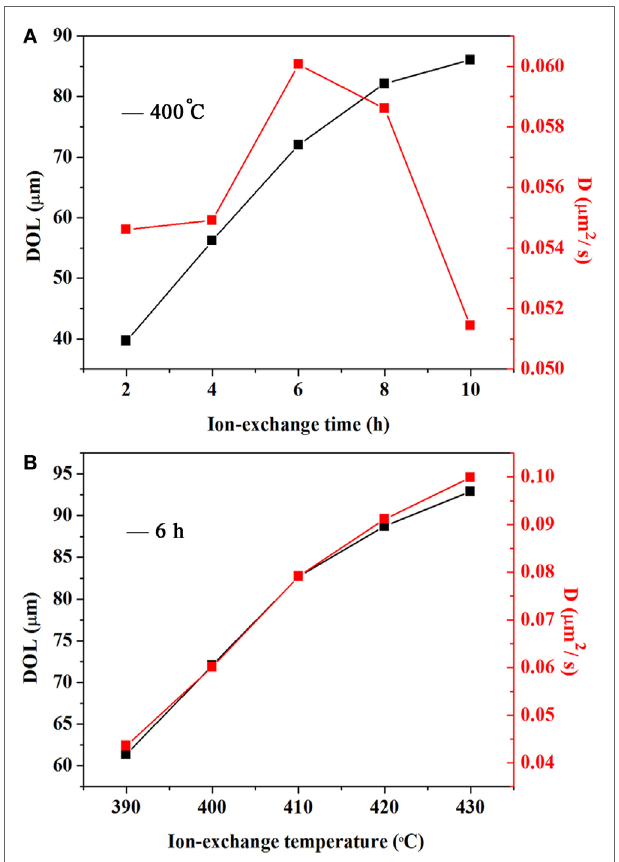
FigUre 1 | DOl and diffusion coefficient of ion-exchanged x P 2 O 5 – (100 − x )(0.25na 2 O–0.08al 2 O 3 –0.67siO 2 ) ( x = 5) glass . (a) DOL and diffusion coefficient of the glass treated at 400°C for different ion-exchange durations; (B) DOL and diffusion coefficient of the glass treated at different ion-exchange temperatures for 6 h.